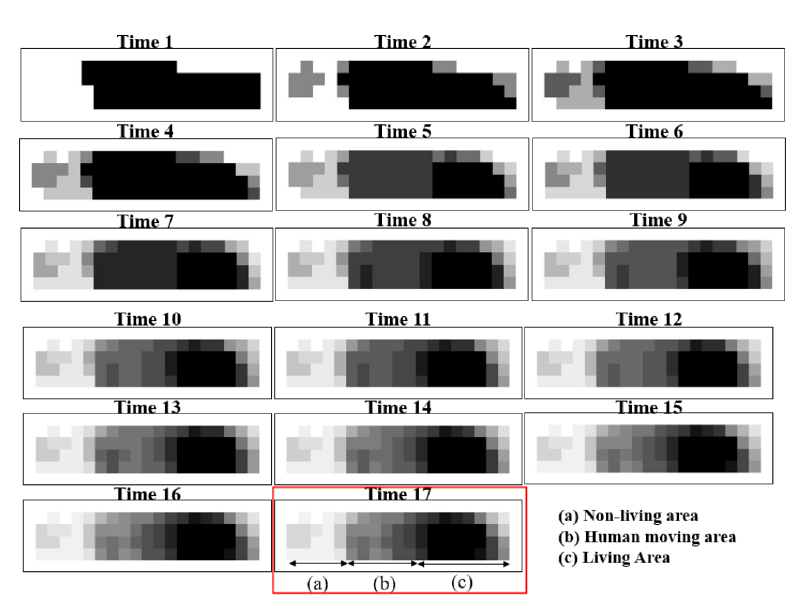
Figure 17. Experiment result based on